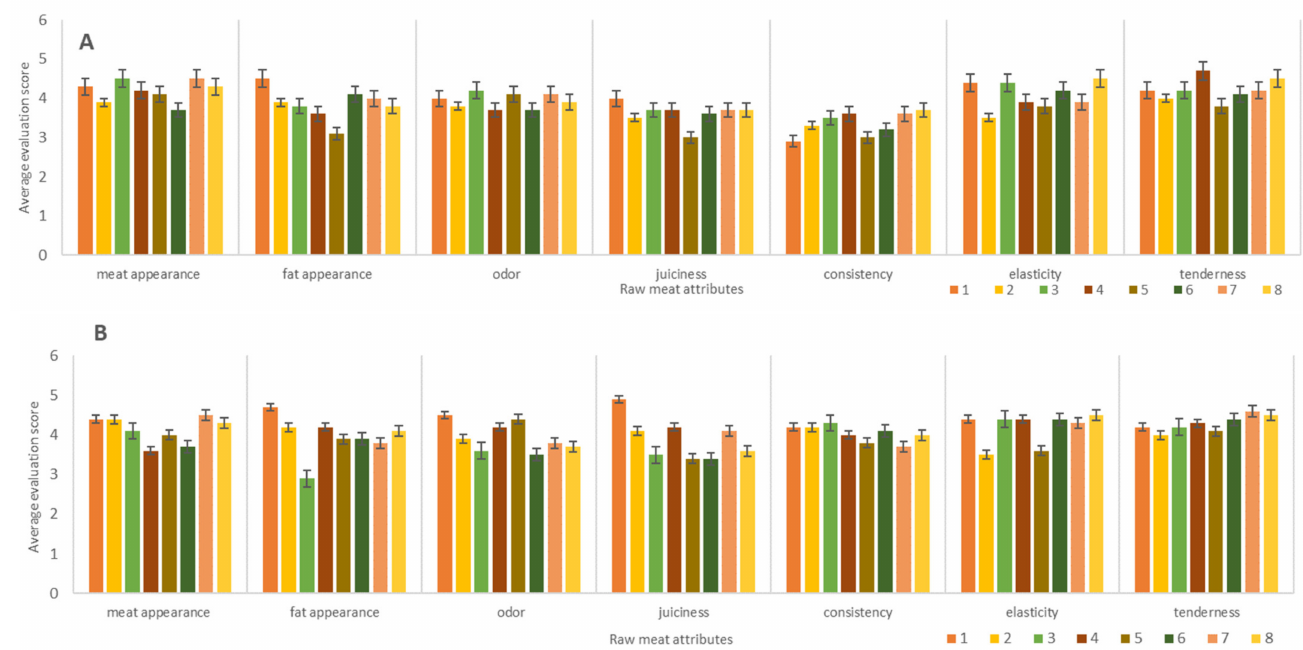
Figure 1. Yeasts supplemented broiler’s breast ( A ) and thigh ( B ) meat sensorial attributes. 1—Negative control group–fed with basal diet (Corn-soybean meal); 2—Basal diet + SC 0.6 g/kg feed; 3—Basal diet + SC 1.0 g/kg feed; 4—Basal diet + SC 1.3 g/kg feed; 5—Positive control group–fed with basal diet (Corn-soybean meal) + RM (0.3 kg/t feed); 6—Basal diet + SC 0.6 g/kg feed + RM (0.3 kg/t feed); 7—Basal diet + SC 1.0 g/kg feed + RM (0.3 kg/t of feed); 8—Basal diet + SC 1.3 g/kg feed + RM (0.3 kg/t